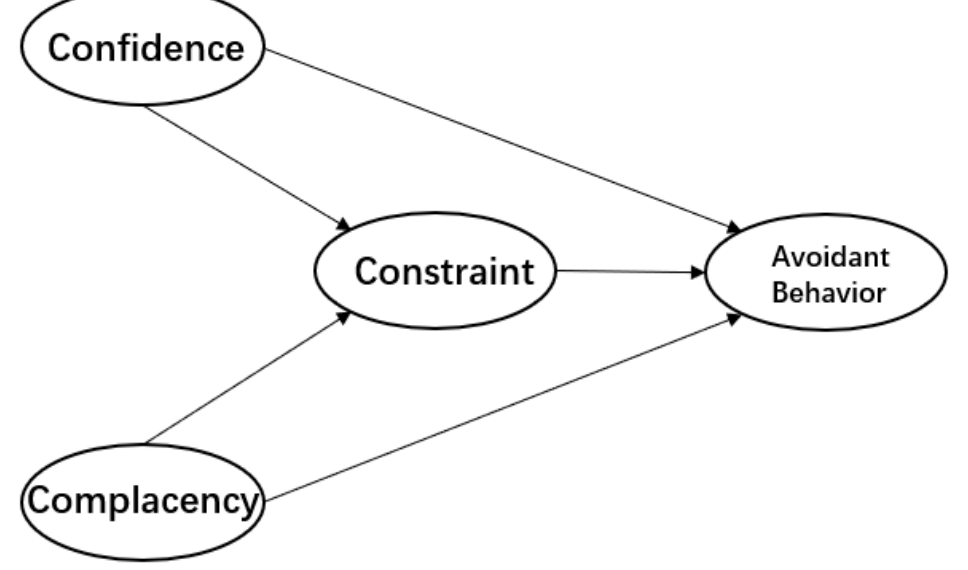
Figure 1. The Conceptualized 3C-avoidant behavior model. Table 6. 3C-avoidant behavior